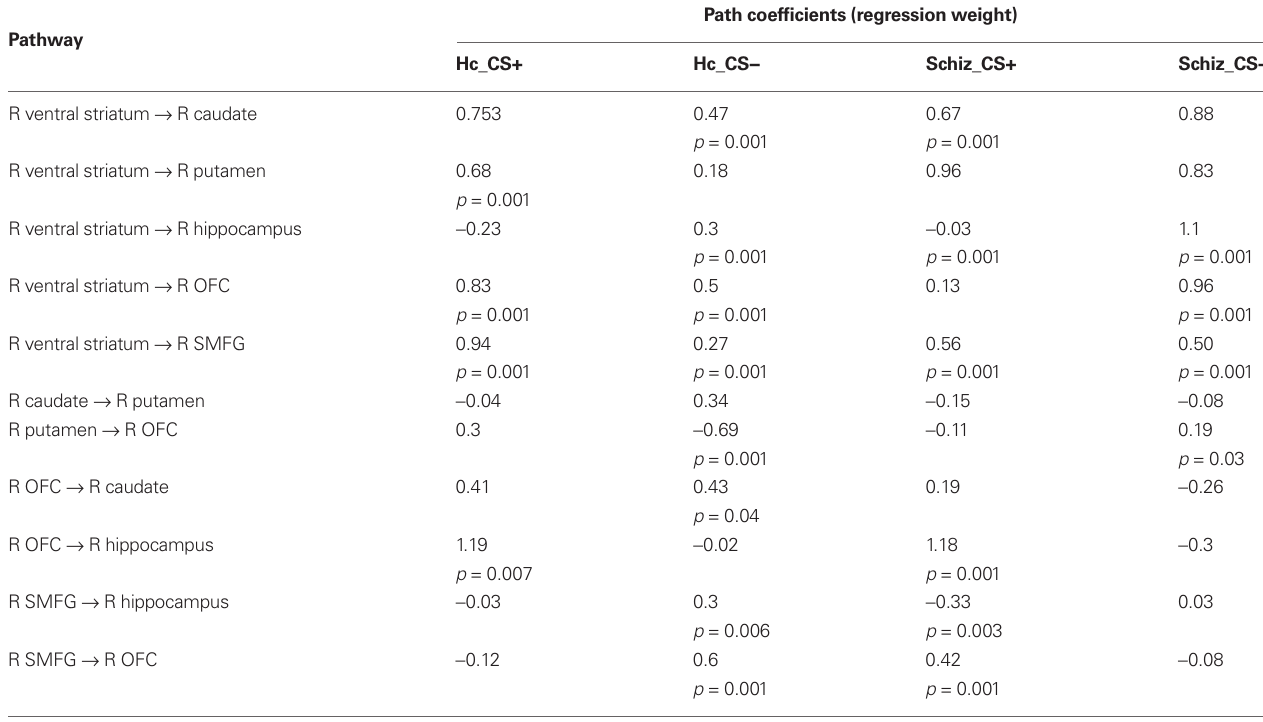
Table 4 | Path coefficients and p values of the omnibus test across the two conditions and two groups.